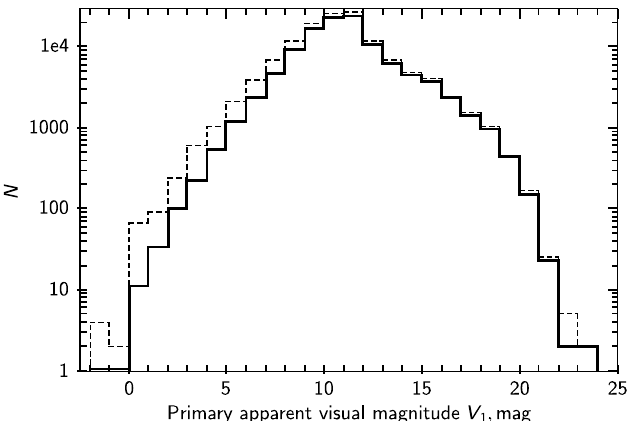
Fig. 2. Distribution of primary component magnitudes of all WCT pairs (the dashed line) compared to that after correction for multiples with only one brightest pair left for every multiple system (the solid